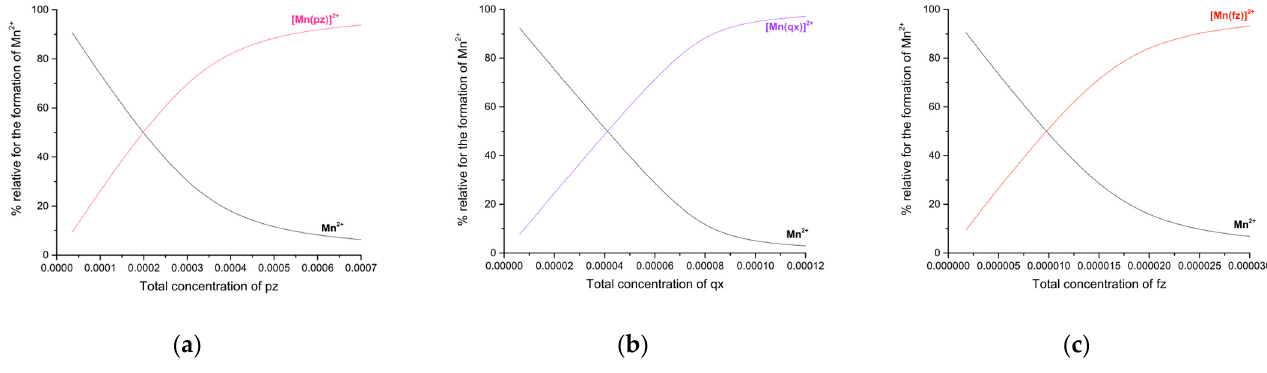
Figure 8. ( a ) Formation curves of the manganese(II)–pyrazine complexes in methanol. [Mn] 2+ = 348 µM and pyrazine range from 35 to 706 µM. ( b ). Formation curves of the manganese(II)–quinoxaline complexes in methanol. [Mn] 2+ = 80 µM and quinoxaline range from 6 to 123 µM. ( c ). Formation curves of the manganese(II)–phenazine complexes in methanol. [Mn] 2+ = 17.5 µM and phenazine range from 1.78 to 35.5 µM.